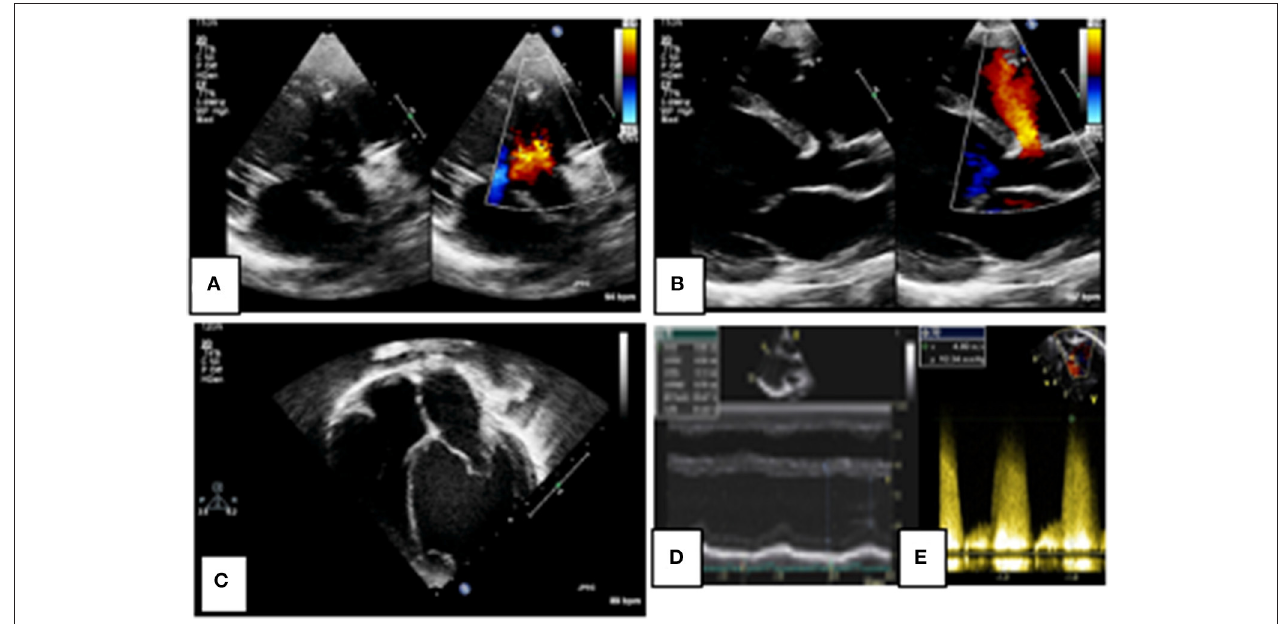
FIGURE 3 | 2D echocardiographic assessment of a peri-membranous ventricular septal defect (VSD). Figures (A,B) define the site and size of the lesion as a small peri-membranous VSD with a left-to-right shunt on color Doppler. There is evidence of left atrial and ventricular dilation in figure (C) indicating a significant left-to-right shunt, as measured on M-mode (D) . The shunt velocity is high on spectral Doppler indicating favorable hemodynamics for VSD closure (E) .